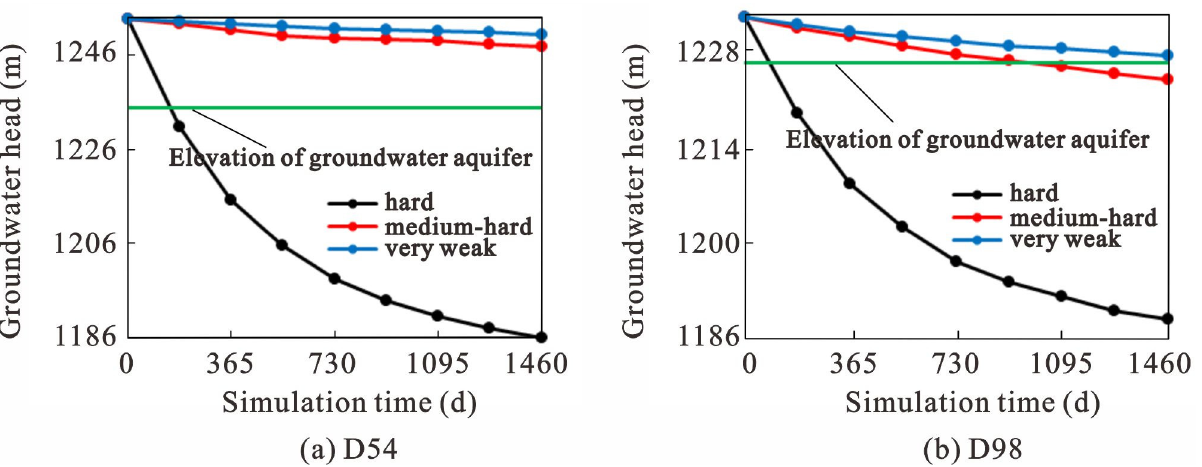
Figure 12. Variation in groundwater level in the upper aquifer system under different lithologies of overlying strata: ( a ) D54, ( b ) D98.